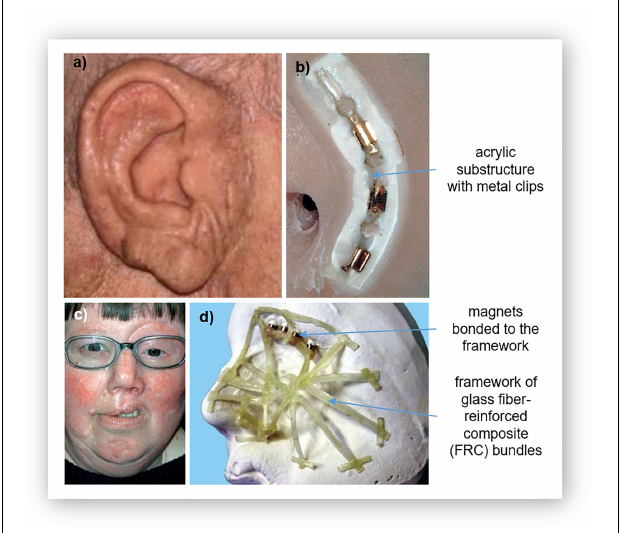
FIGURE 2 | Acrylic substructures for silicone prostheses: (a) a prosthetic ear and its (b) substructure for clip attachment, and (c) a large facial prosthesis and its (d) glass fiber-reinforced composite (FCR) substructure for reinforcement. Reproduced with permission from Elsevier (Ciocca et al., 2007; Kurunmäki et al.,